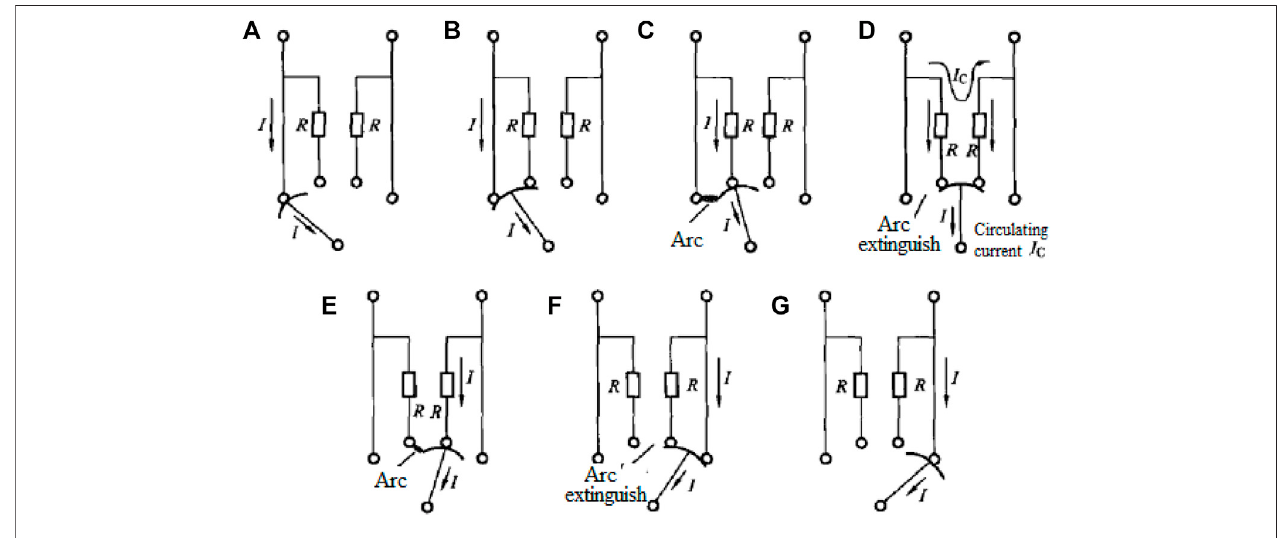
FIGURE 2 | Switching process of dual-transition resistance-type OLTC.